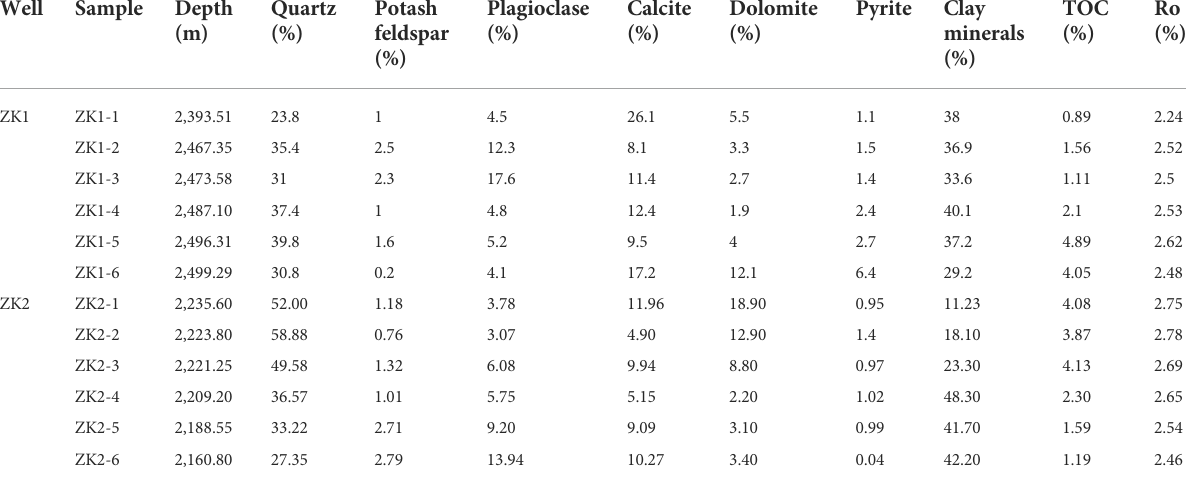
TABLE 1 Mineral composition and vertical changes in the Wufeng-Longmaxi Formation shale in the Changning area. Well